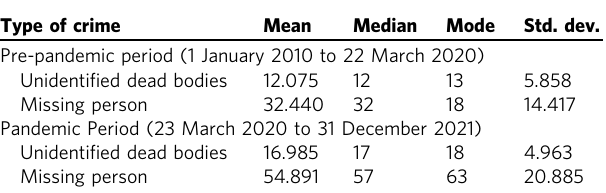
Table 1 Descriptive statistics: central tendencies for all crimes in both pre-pandemic and pandemic periods. Type of